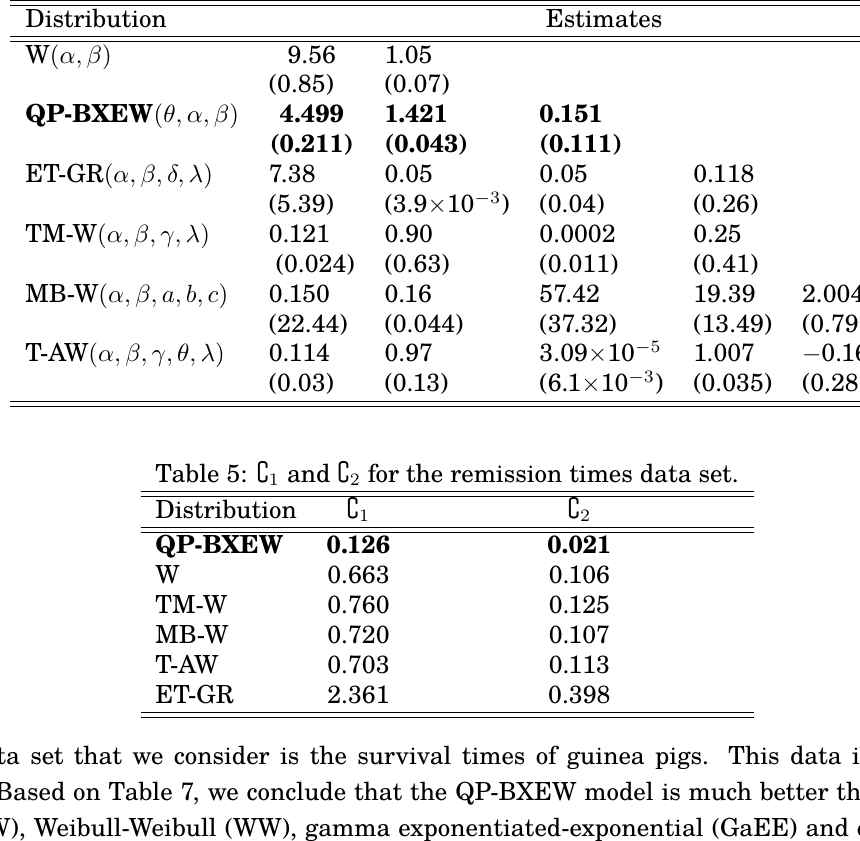
Table 4: MLEs and SEs for the remission times data.